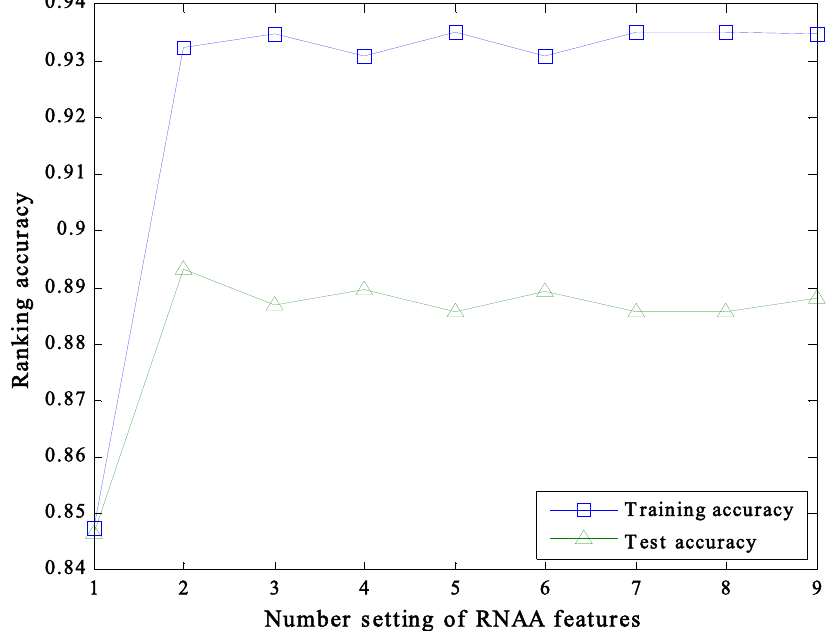
τ Figure 5. RAL ranking accuracy with different LVIS metric combinations learned with RNAA Figure 5. RAL ranking accuracy τ with different LVIS metric combinations learned with RNAA in in Table 3. Table 3.